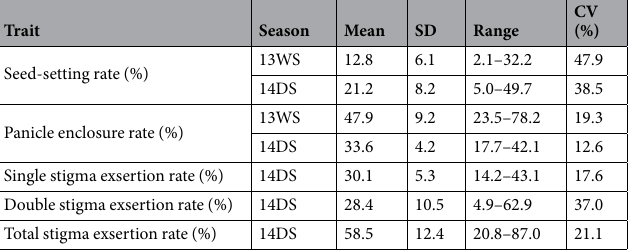
Table 1. Phenotypic performance of five traits of 217 rice male sterile lines. 13WS = wet season of 2013; 14DS = dry season of 2014; SD = standard deviation, based on the measured values of three replications; CV = coefficient of variation, calculated as the ratio of the standard deviation to the mean value.